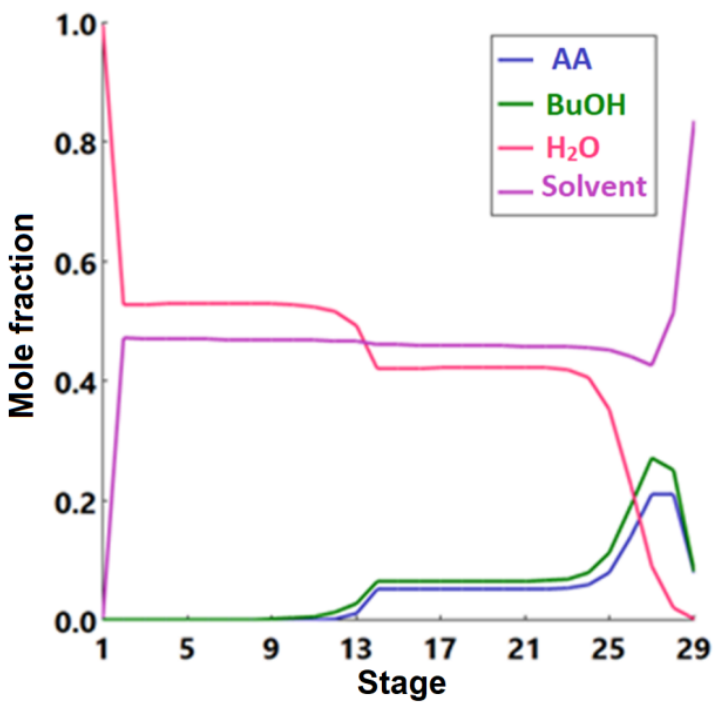
Figure 15. Liquid-phase molar compositions of components inside the extractive distillation column as a function of stage number.